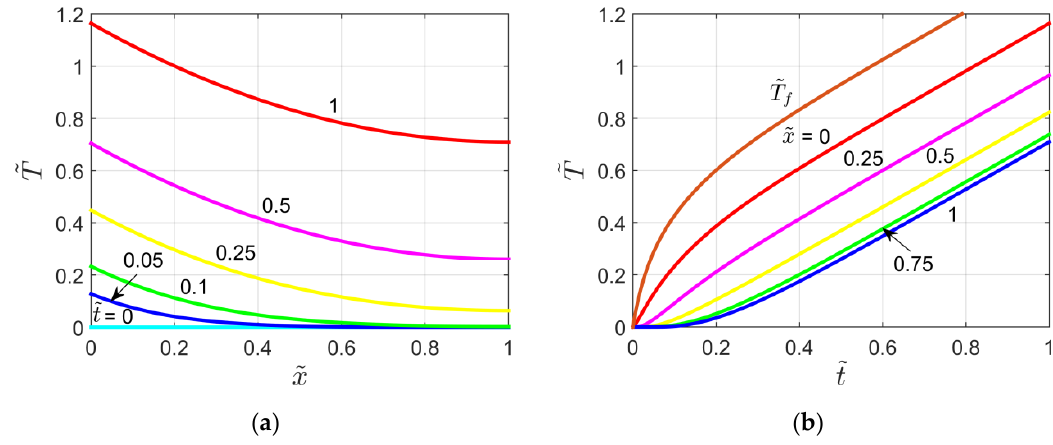
~ ~ and x as a parameter ( P = 1 and